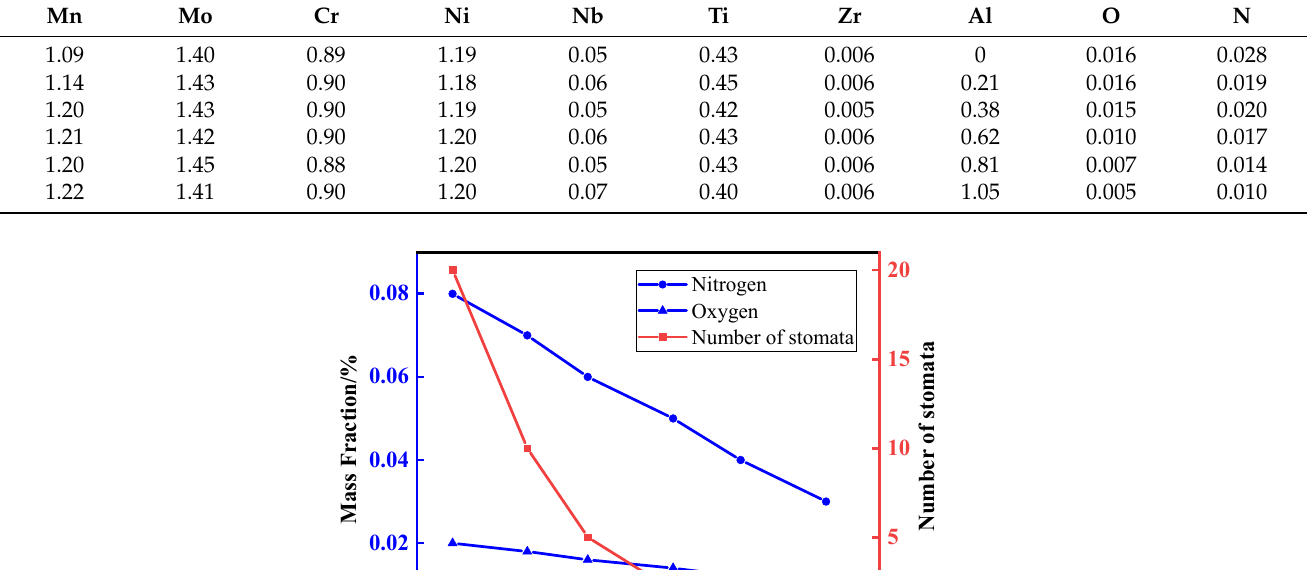
Table 4. Chemical composition of weld metal (mass, wt%).